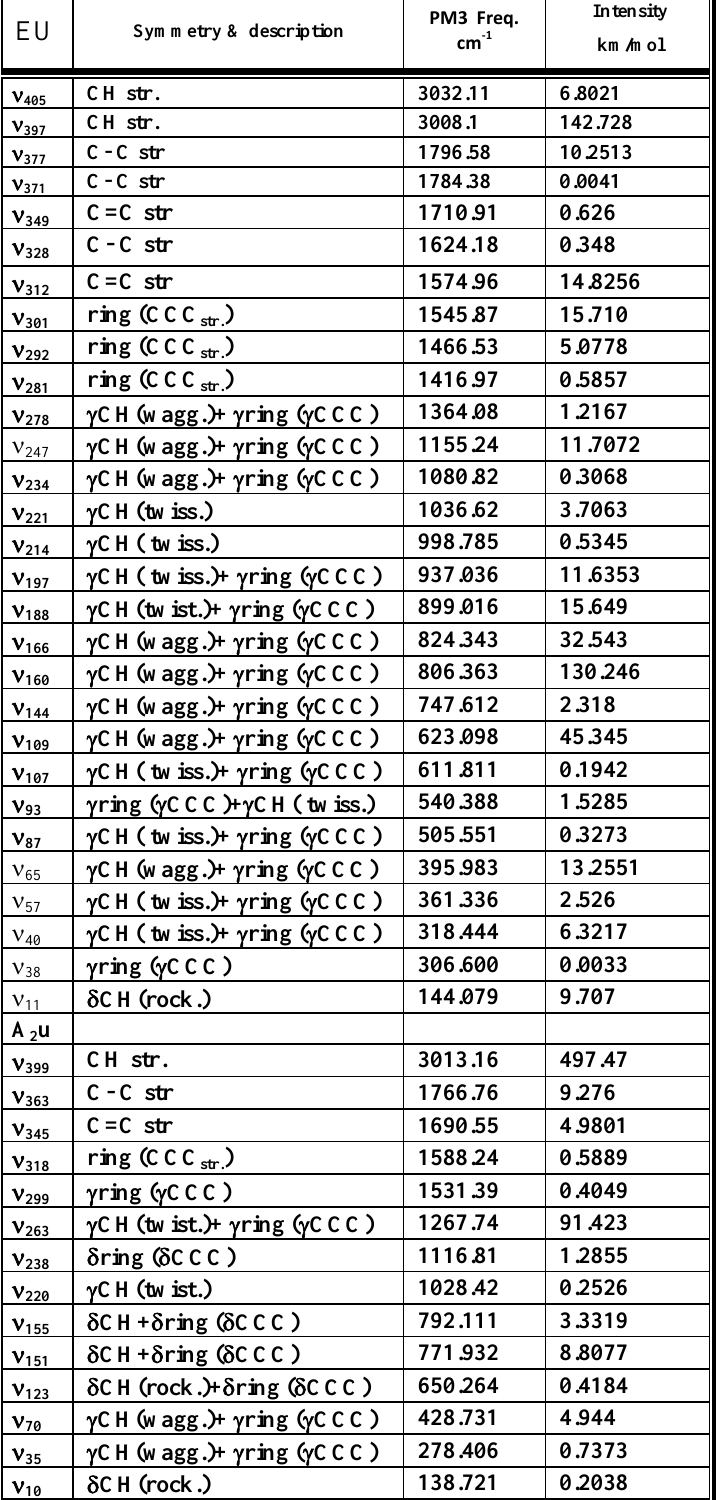
Table 5: Vibration frequencies and IR absorption intensities for (di-rings layer (C calculated applying G03 program by PM3